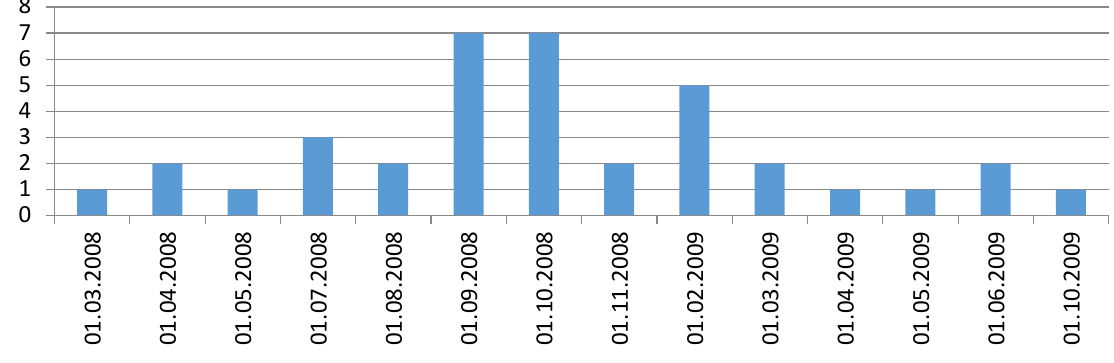
Figure 6. Frequency of overreactions in the UX index over the period 2008–2009 (monthly data)